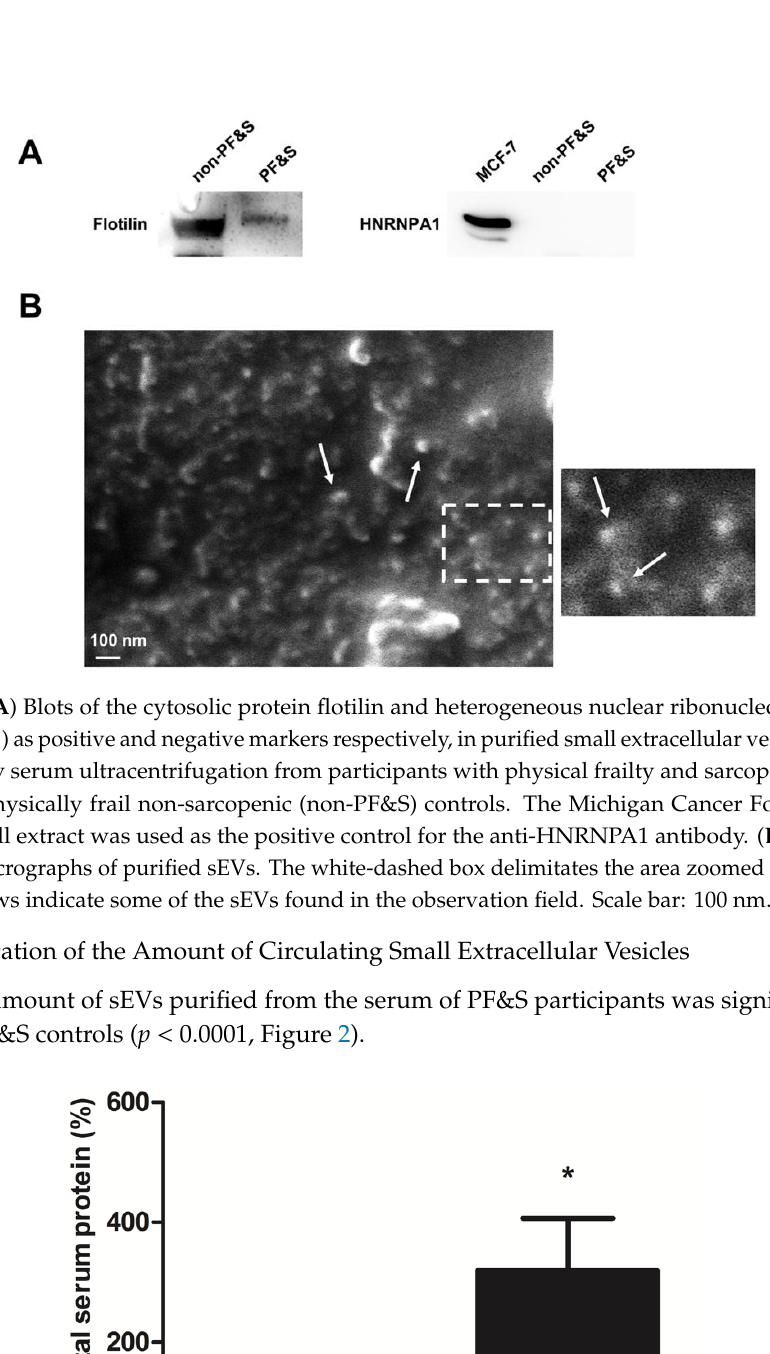
Figure 3. Protein expression of ( A ) CD9, ( B ) CD63, and ( C ) CD81 in purified small extracellular vesicles (sEVs) from non-physically frail non-sarcopenic (non-PF&S) controls (n = 10) and participants